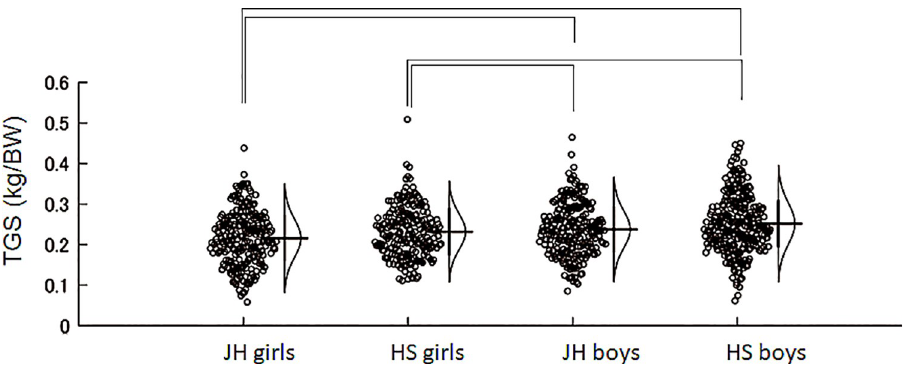
Fig 1. Jitter plots of the toe gripping strength per body weight for each group. The curves on the right side of the plots indicate the estimated gaussian distribution of each group. All brackets indicate significant difference between groups. Post-hoc tests revealed significant differences between sexes, but no significant differences between age groups. JH: junior high school, HS: high school, TGS: toe gripping strength.